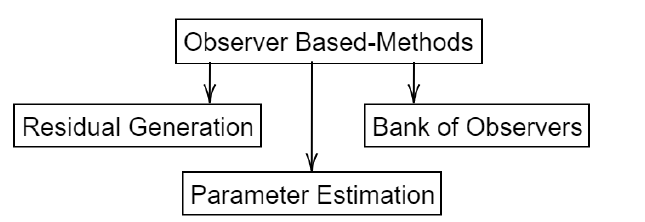
Figure 7. Methods based on state observers for diagnosing faults in the stators of BLDC motors.